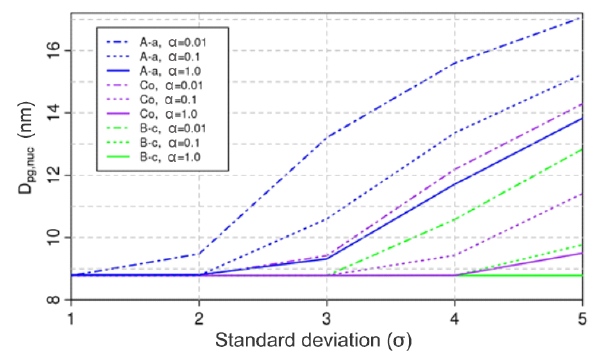
Figure 8. Nucleation-mode peak diameter D p (nm) at 100s of simulation depending on the mass accommodation coefficient, the vapour pressure parameterisation, and the composition standard deviation. The initial nucleation-mode peak diameter is at 23nm (not shown in the figure). Results are shown for 1% initial non- volatile material in the nucleation-mode particles, modal composi- tion C 16 H 34 , and for various composition standard deviations. The vapour pressure parameterisations are labelled as in Fig.